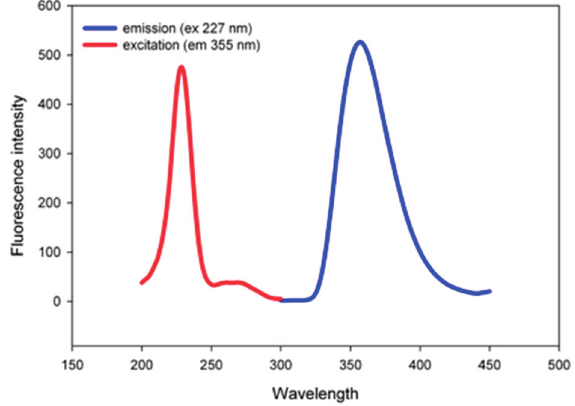
Figure 2. Excitation and emission spectra of